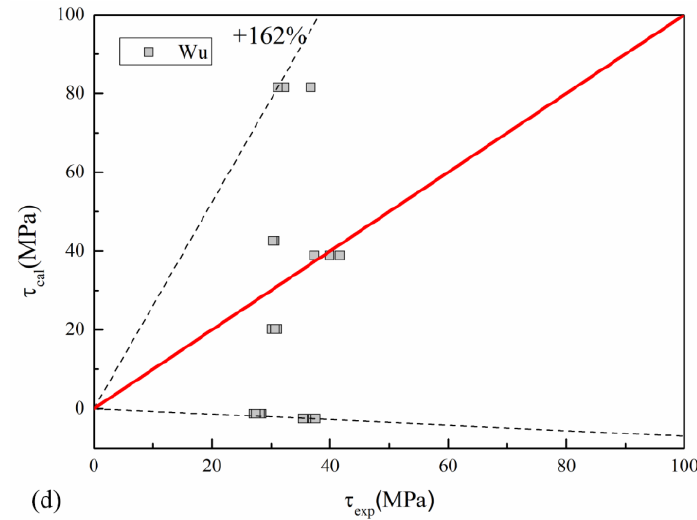
Figure 11. Comparison of ultimate bond strength between various models and test data. ( a ) GB50010-2010 [19] ( b ) AS-3600 [25] ( c ) ACI 318-05 [26] ( d ) Wu [27].